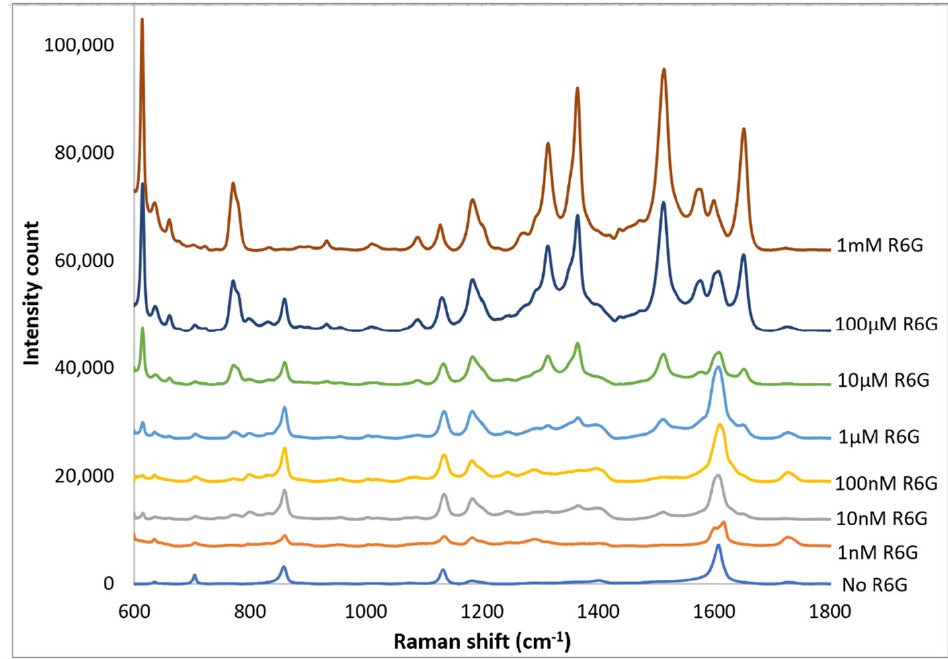
Figure 9. Top traces, Raman spectrum of 1 nm to 1 mm concentrations of R6G obtained after drop- casting silver nano-sphere suspension on imprinted PETE-1. Bottom trace, no R6G. For clarity the spectra have been offset vertically.